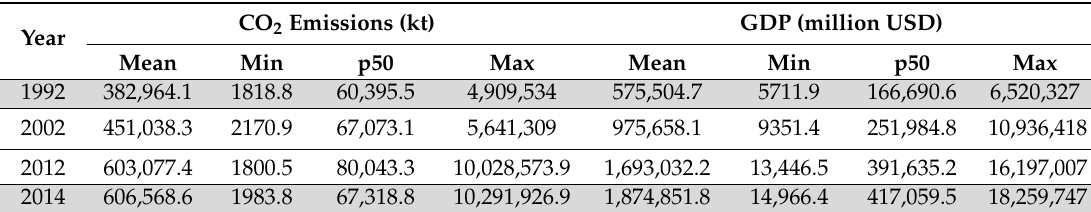
Table 3. Descriptive Statistics of the 37 Case